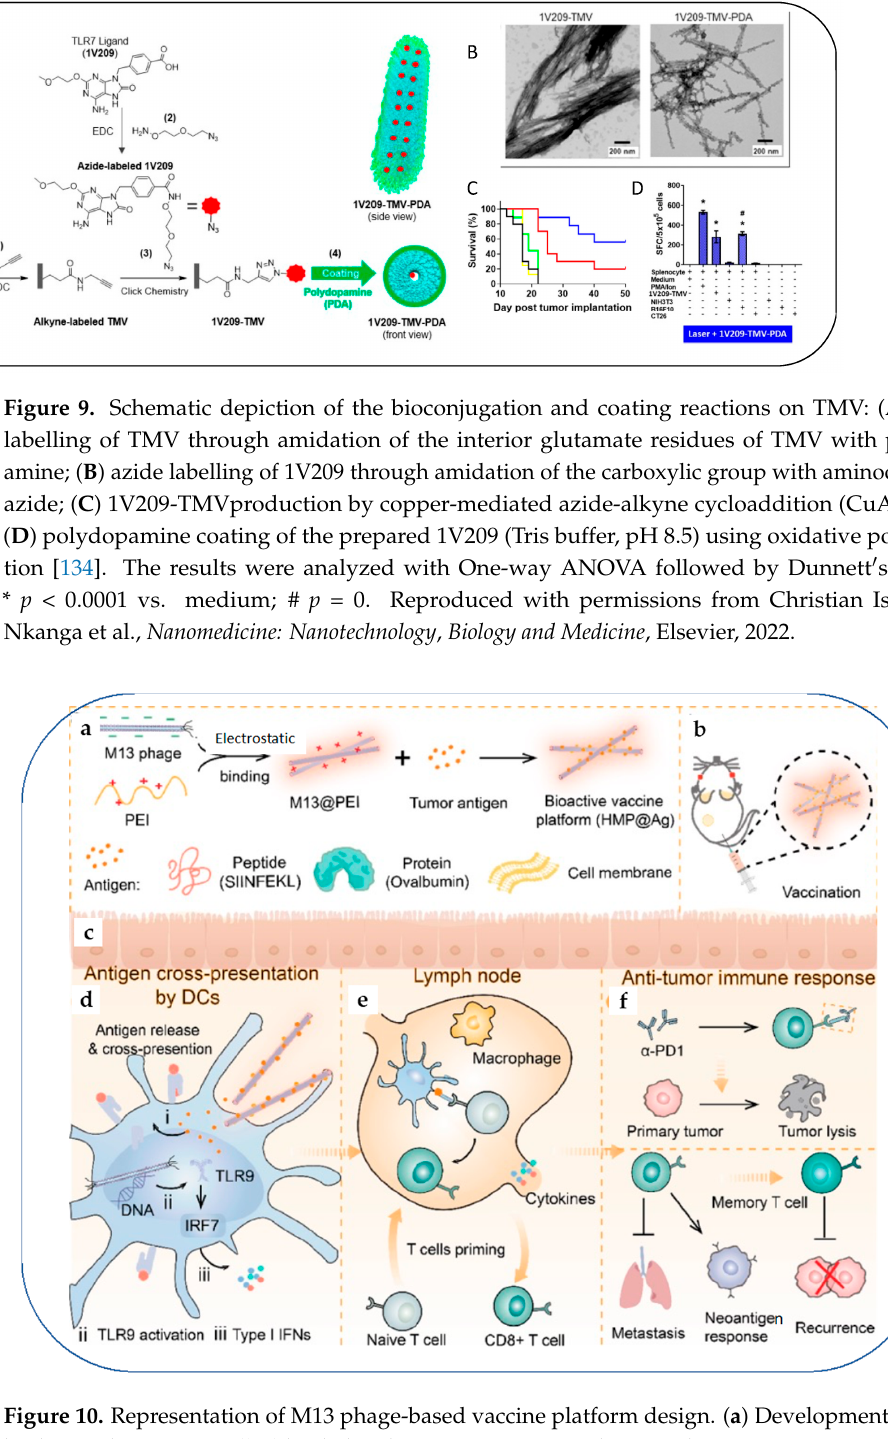
Figure 9. Schematic depiction of the bioconjugation and coating reactions on TMV: ( A ) alkyne la- belling of TMV through amidation of the interior glutamate residues of TMV with propargyl amine; ( B ) azide labelling of 1V209 through amidation of the carboxylic group with aminooxy-PEG1-azide; ( C ) 1V209-TMVproduction by copper-mediated azide-alkyne cycloaddition (CuAAC); and ( D ) pol-